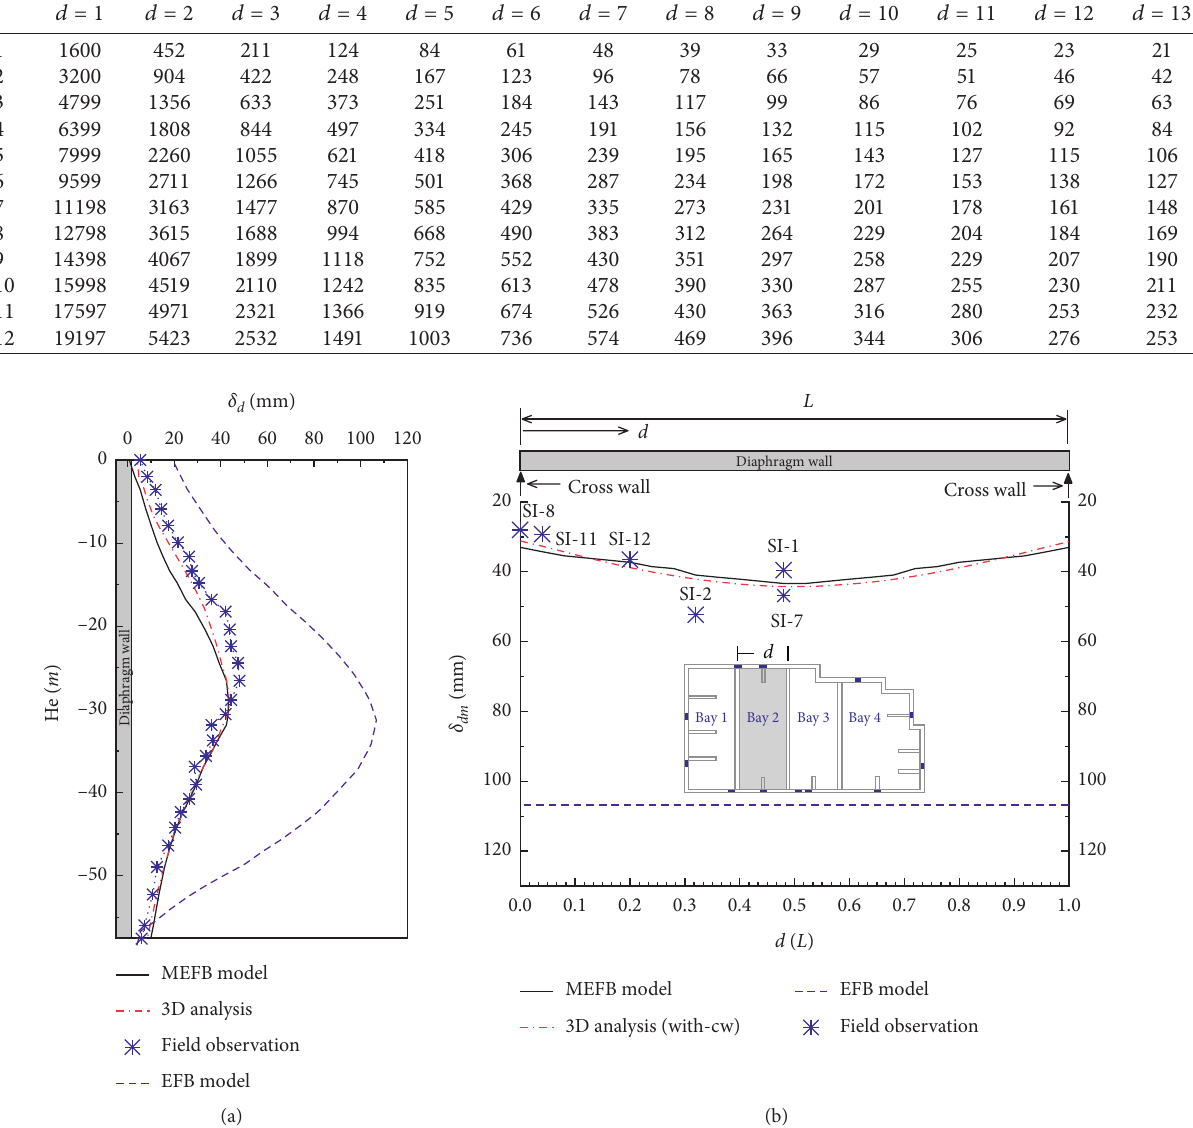
Figure 12: Comparison of the computed maximum lateral wall deflections at various sections and those from field observation for case 2. (a) Wall deformation at SI-8. (b) Wall deformations at GL-30.0m in various cross-sections (d/L).